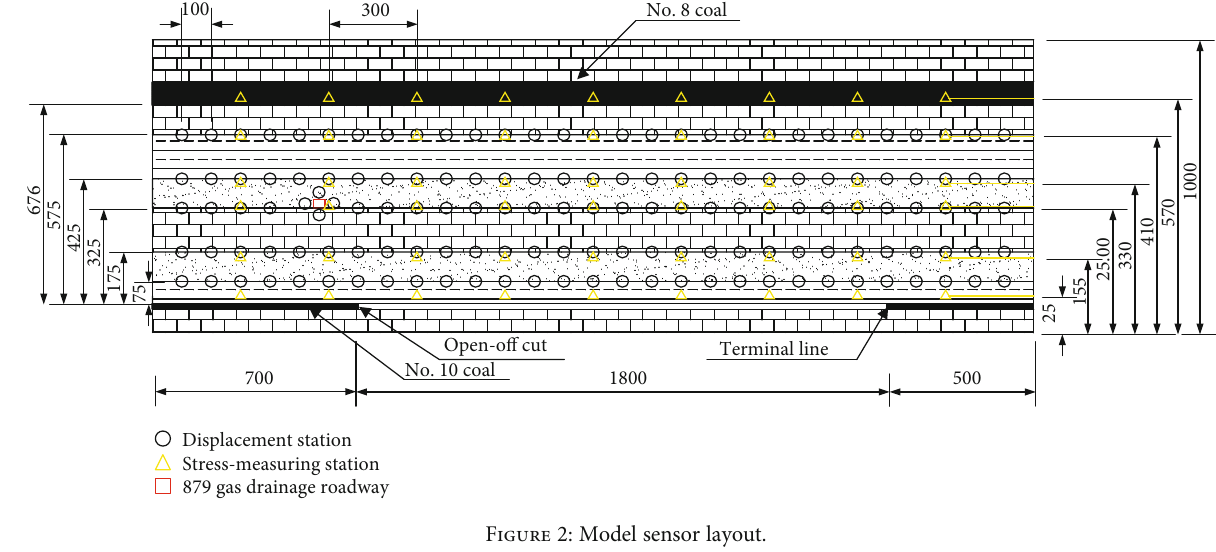
Figure 2: Model sensor layout.